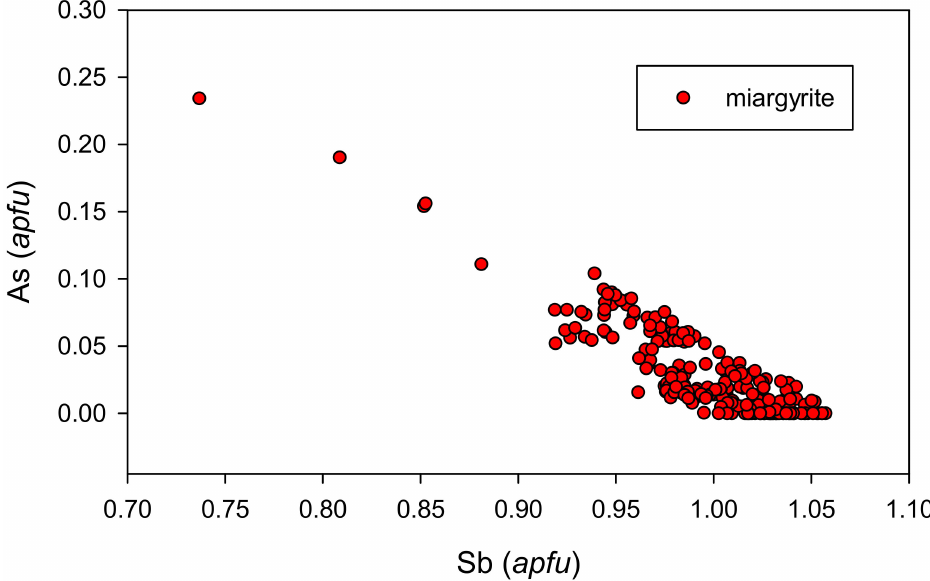
Figure 9. Graph of Sb vs. As ( apfu ) for miargyrite from the Kremnica deposit.